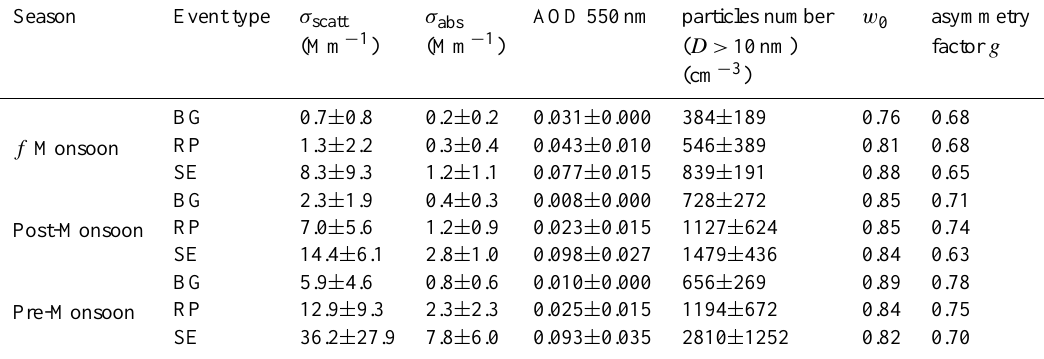
Table 1. Averaged aerosol optical properties found in the 3 types of events for each considered season excluding winter season. Season Event type σ scatt σ abs AOD 550nm particles